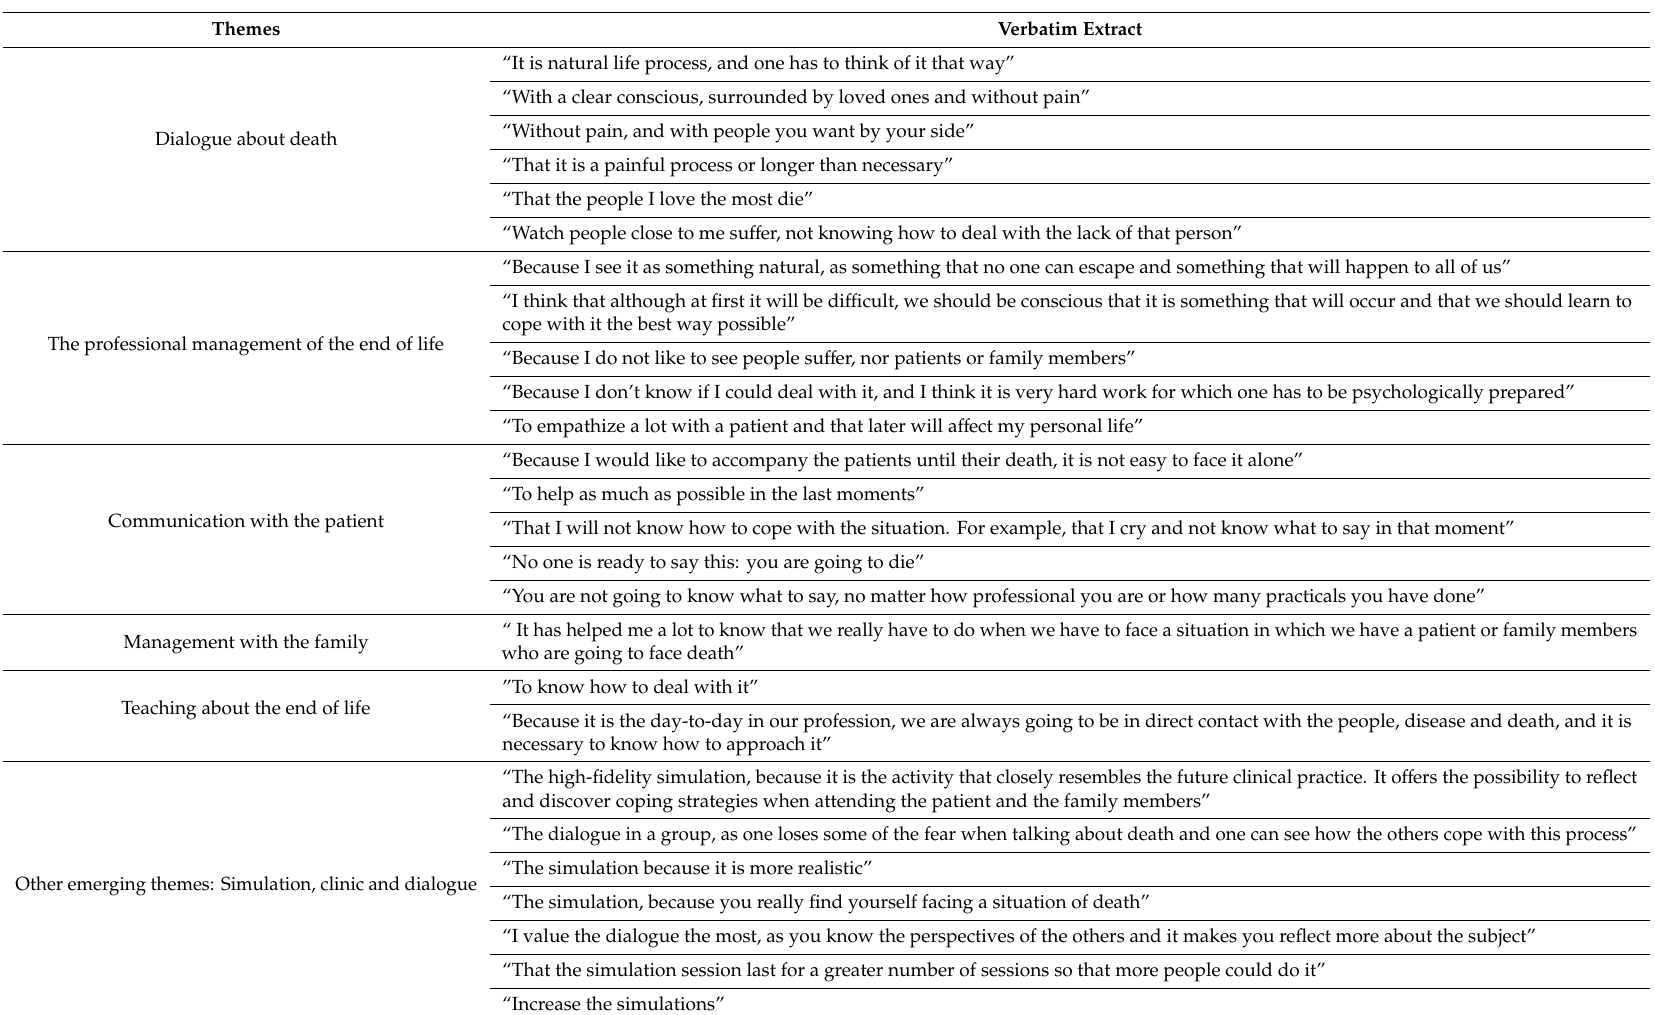
Table A3. Themes and verbatim